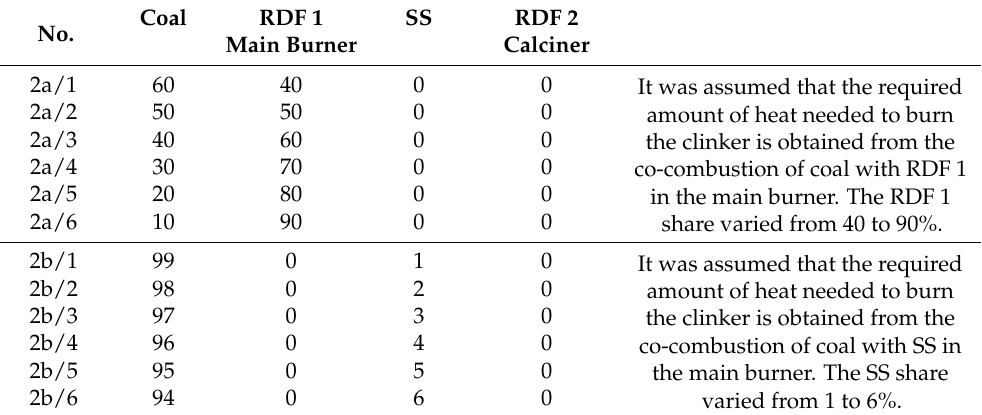
Table 2. The heat distribution in the three-component blends, (in